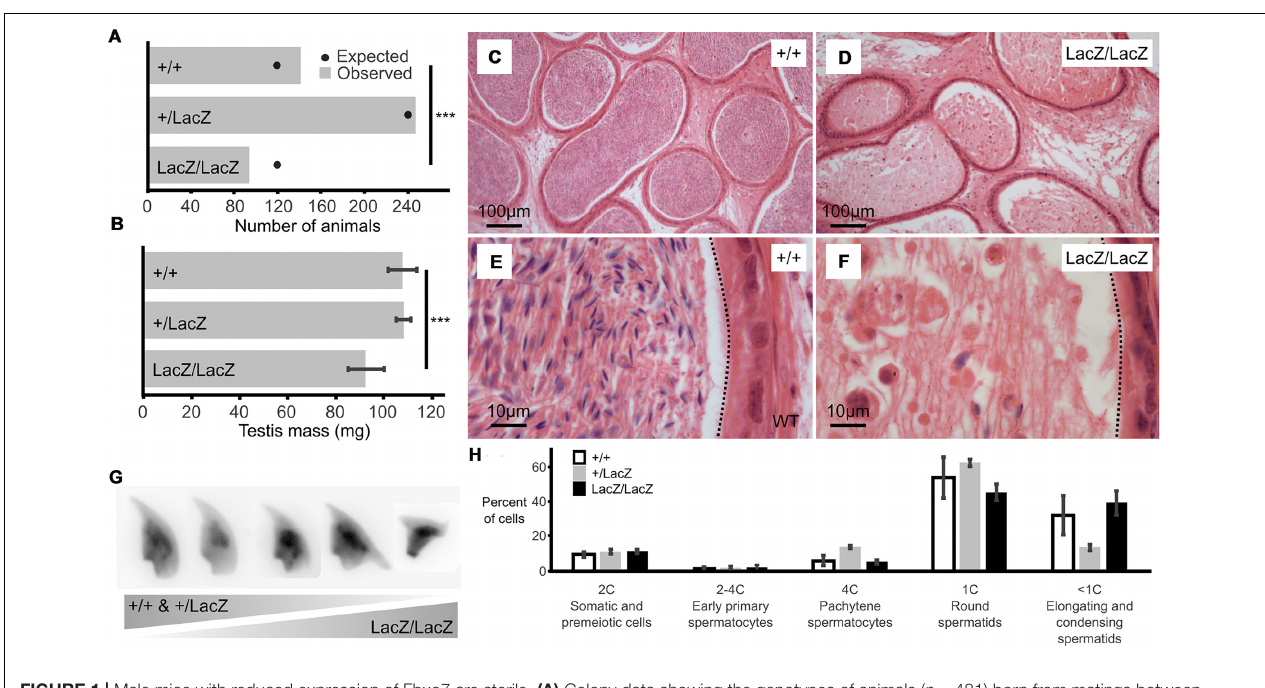
FIGURE 1 | Male mice with reduced expression of Fbxo7 are sterile. (A) Colony data showing the genotypes of animals ( n = 481) born from matings between heterozygous parents. All three potential genotypes are observed in the offspring, but the proportion of homozygous Fbxo7LacZ/LacZ offspring is lower than expected ( ∗∗∗ chi-squared goodness-of fit test p = 0.007 vs. Mendelian 1:2:1 expectation). (B) Average testis weight for each genotype ( n = 6; WT and homozygous; n = 4, heterozygous LacZ; One-way ANOVA, ∗∗∗ p = 0.001067). (C) Wild type cauda epididymis showing large numbers of stored sperm. (D) Fbxo7LacZ/LacZ cauda epididymis showing very few degenerating sperm. (E,F) High resolution zoom of sections (C,D) . Dotted line indicates the border of the tubule lumen in each view. (G) Montage of DAPI-stained sperm nuclei showing the spectrum of sperm morphologies present (see also Supplementary Figure S1 ). (H) FACS quantitation of testis cells according to DNA content as measured by propidium iodide staining (note that highly condensed spermatids and mature sperm were not quantitated); n = 4 WT, 2 heterozygous, 2 homozygous LacZ